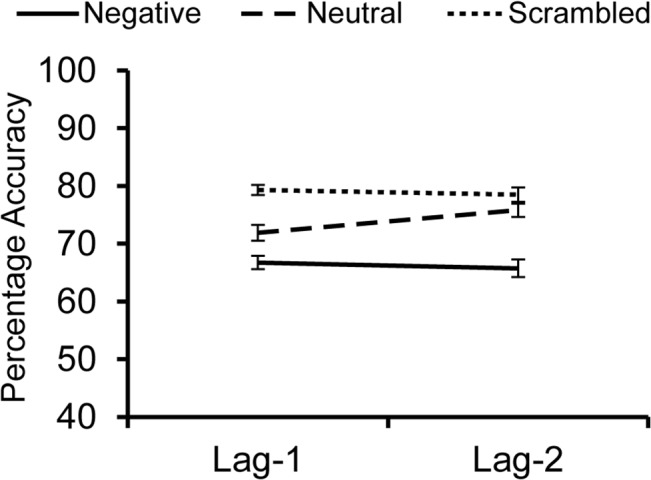
Average percent accuracies for target detection in Experiment 1.Targets were presented one image (lag-1) or two images (lag-2) after negative, neutral, or scrambled distractors. Error bars represent standard error. See text for details.